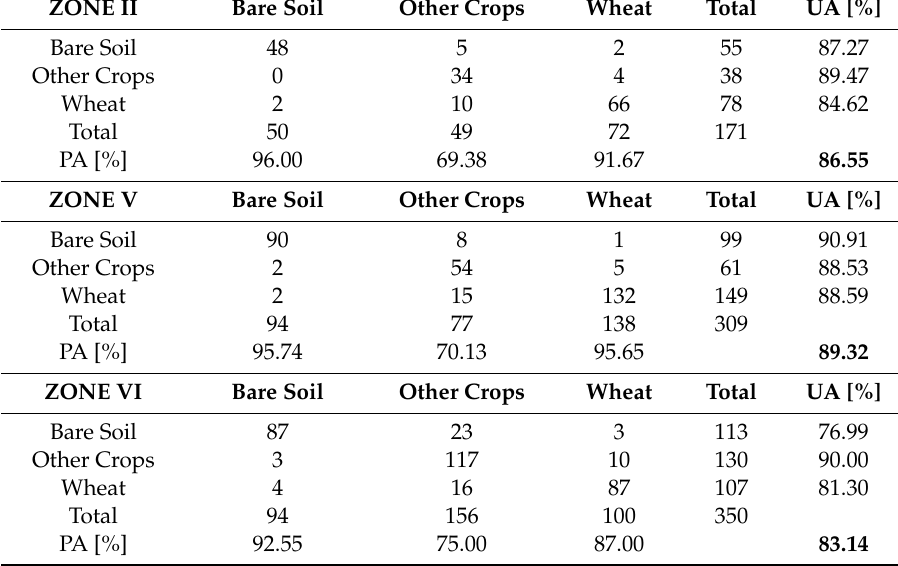
Table 8. Confusion matrixes for the pixel-based crop type classification at the three stratified agrarian regions under study. Zone II in the northern Montaña region, zone V in the Media region, and zone VI in the Ribera Alta Southern region. The confusion matrix was calculated after the object filtering of fields. Thus, the number indicates the classification accuracy of fields and not pixels. UA indicates users’ accuracy and PA producers’ accuracy. The overall accuracy at the bottom right of each zone is highlighted in